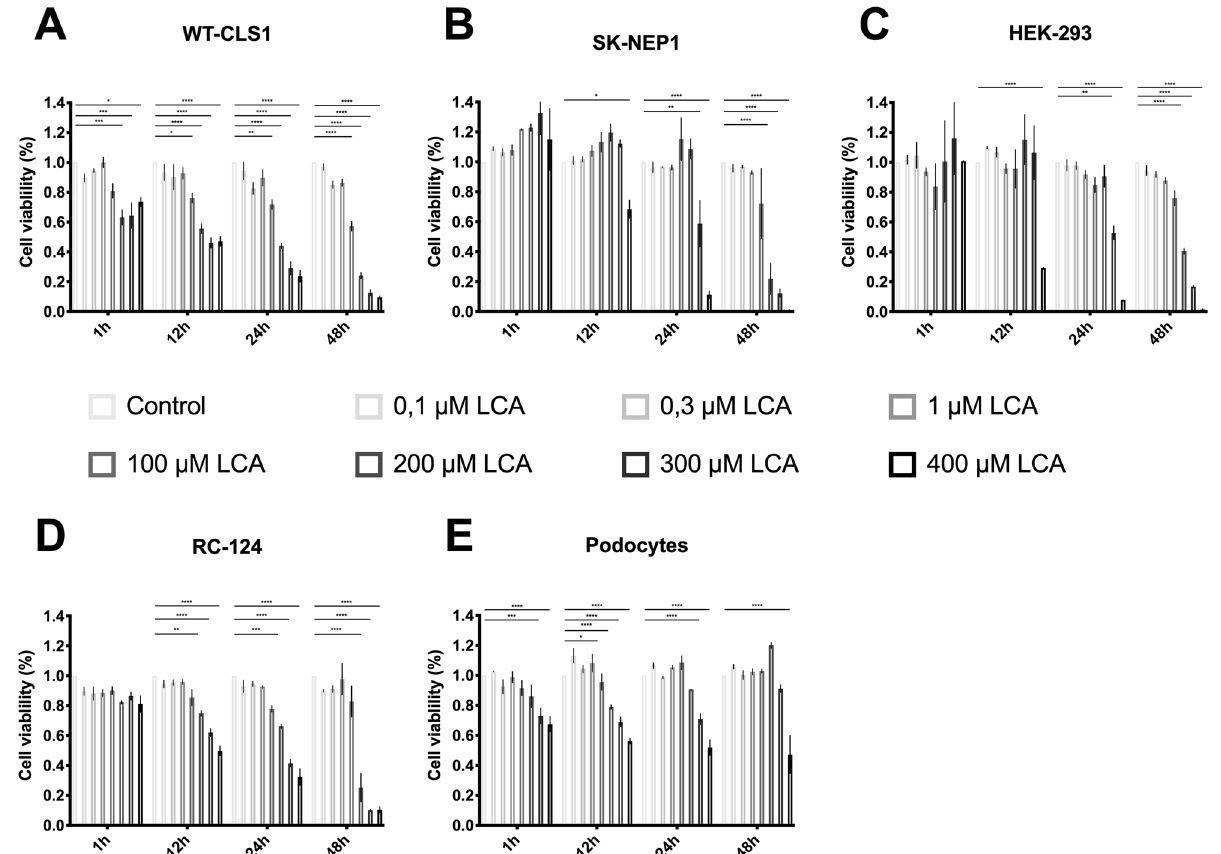
Figure 1. LCA kills cultured human nephroblastoma cells. The percentage of viable cells was calculated using the RealTime-Glo MT Cell Viability Assay . All cell-lines were treated as described in “Methods”. Data were evaluated using Prism and are presented as mean ± SD of values from three independent experiments. Significance level was set as p < 0.05 (*< 0.05; **< 0.005; ***< 0.0005; ****<